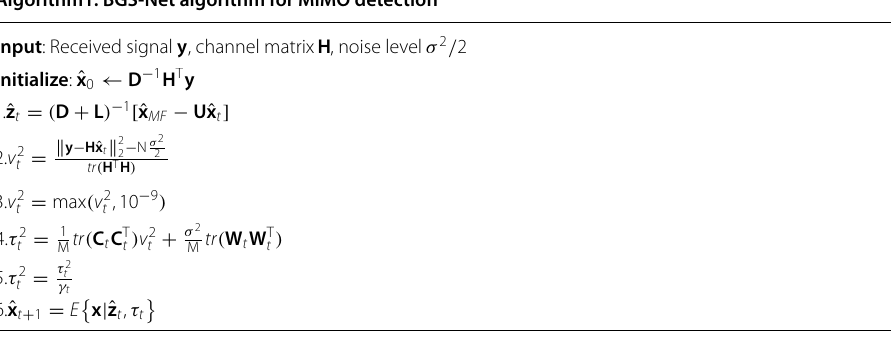
Algorithm1: BGS‑Net algorithm for MIMO detection